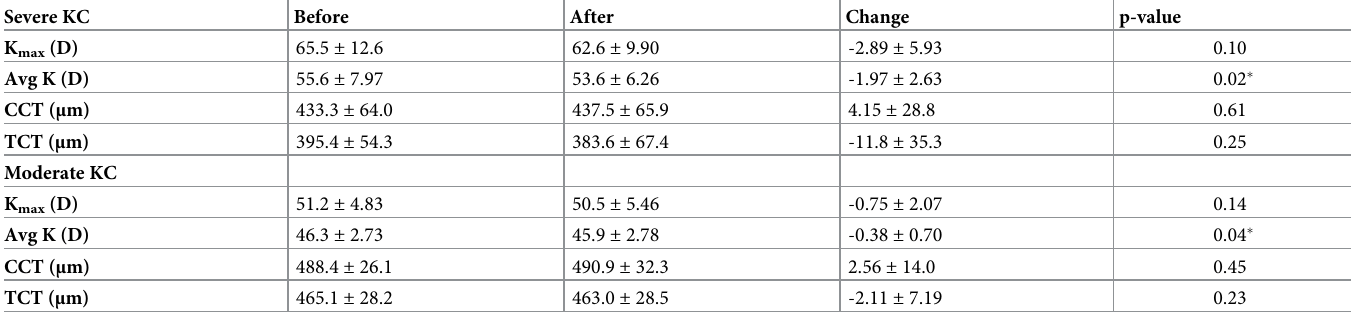
Table 4. Changes in keratoconus progression indices of severe and moderate keratoconus based on the Amsler–Krumeich classification before and after the use of a rigid gas-permeable contact lens. Severe KC Before After Change